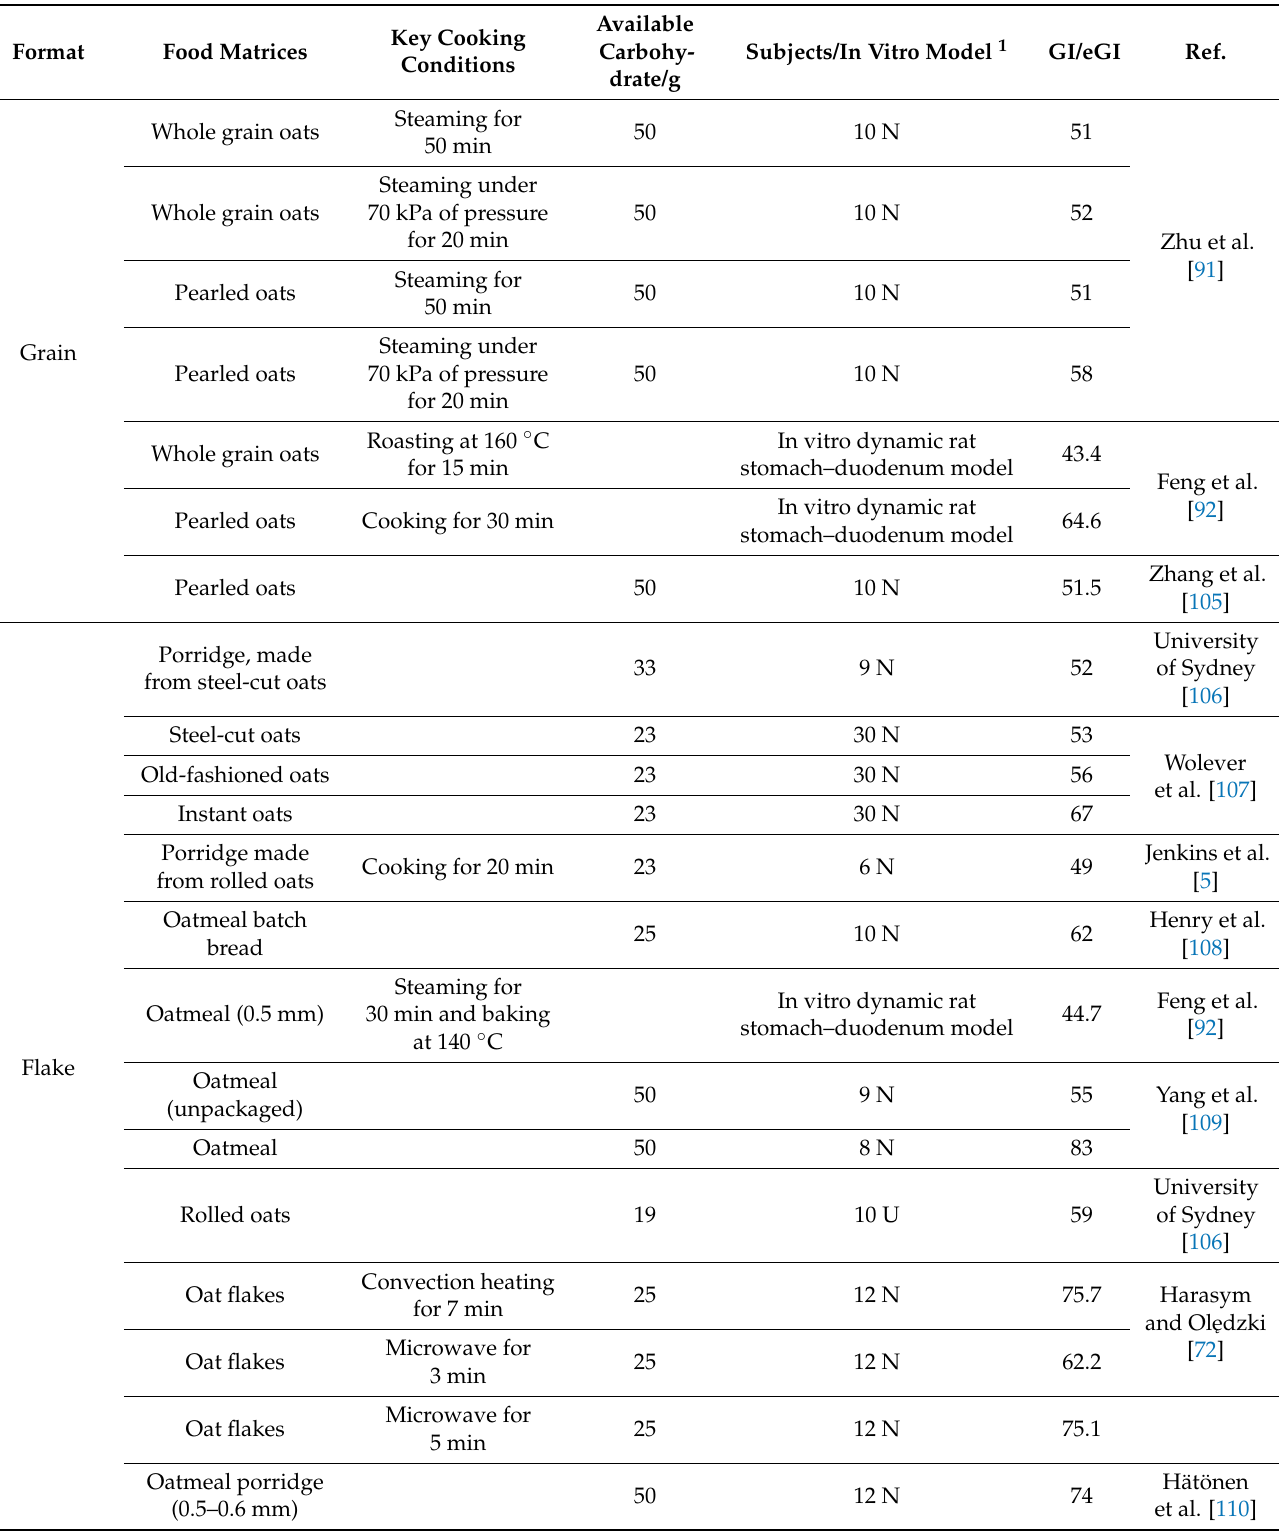
Table 2. GI values of oat-based products with different structural